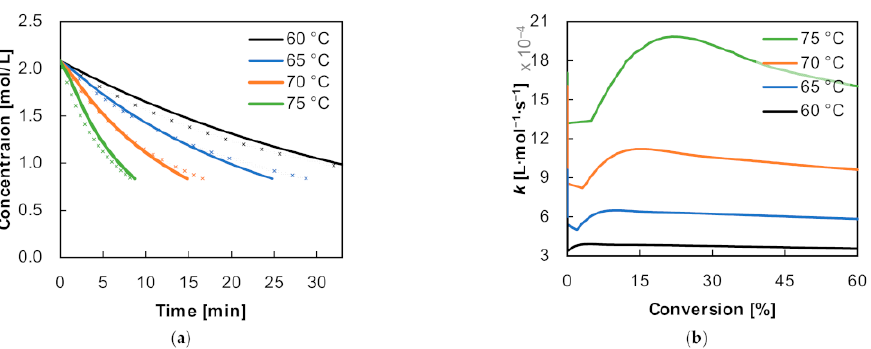
Figure 9. Arrhenius parameter estimation plots of acrylic acid polymerisations in isopropyl alcohol (150 g/L, 1.0 mol% AIBN). ( a ) Plot of the simulated concentration profiles (solid lines) with the Ar- rhenius parameters estimated by Predici and the fitted experimental data (crosses). ( b ) Development of the k-values against the reaction